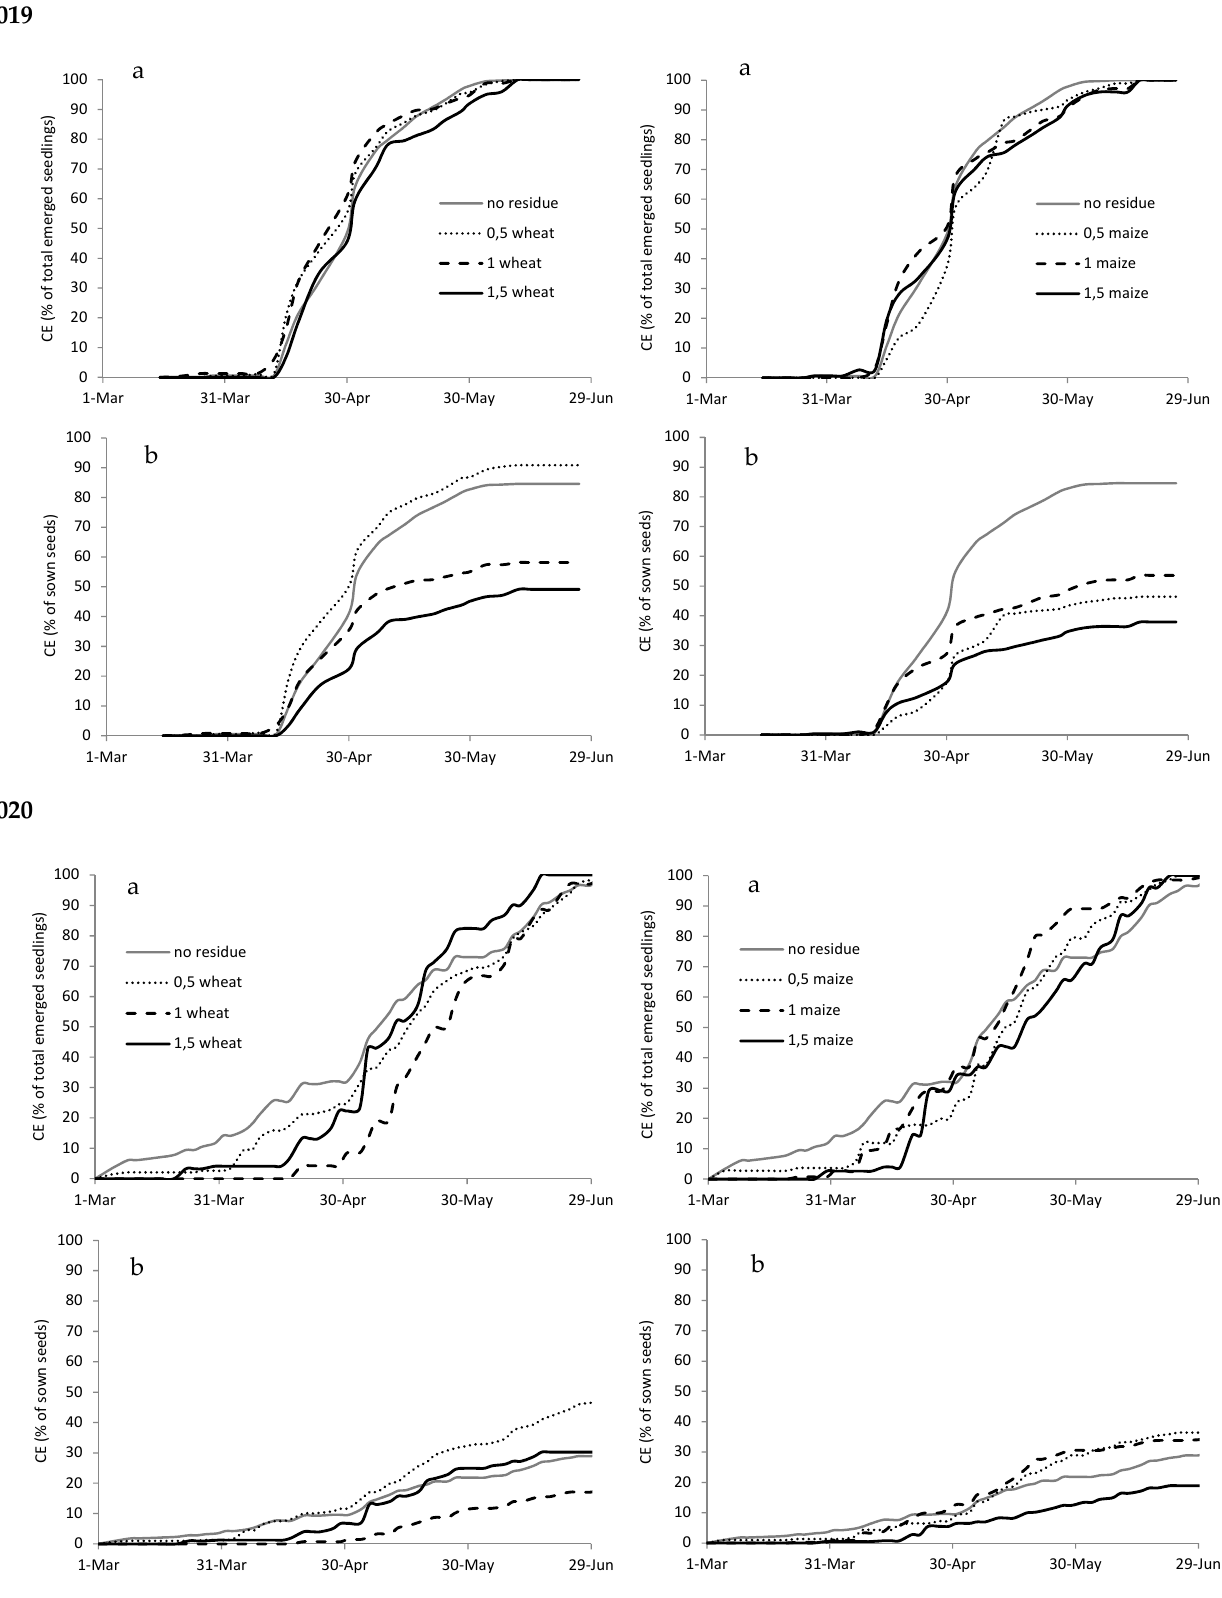
Figure A6. Cumulated emergence (CE) expressed as percentage of total emerged seedlings ( a ) and as percentage of sown seeds ( b ) of Setaria pumila in 2019 and 2020 with different types (wheat on the left and maize on the right) and amounts of crop